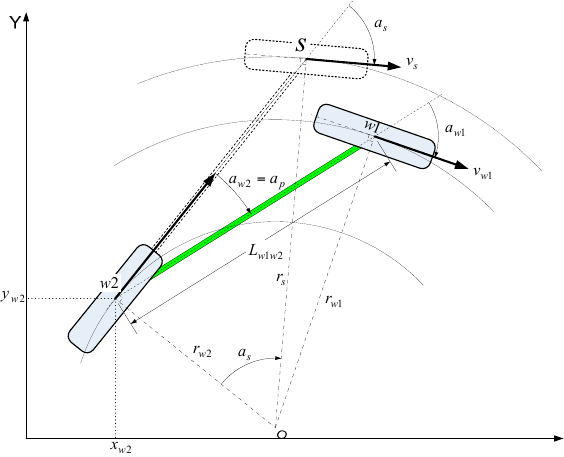
Figure 8. All-wheel steering bicycle model.